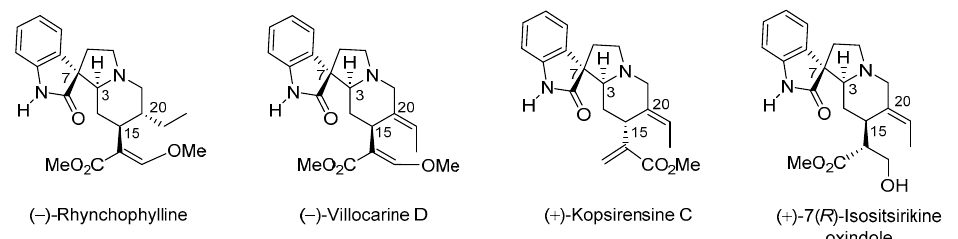
Figure 1. Representative tetracyclic spiro[indolizidine-1,3 ′ -oxindole] alkaloids. The members of this group of alkaloids often occur in nature as pairs of C-7 epimers [15,16], interconvertible under acidic or basic conditions by retro-Mannich/Mannich reac- tions via a ring-opened intermediate [17–20]. Scheme 1 illustrates this equilibrium for geissoschizol oxindoles [16].